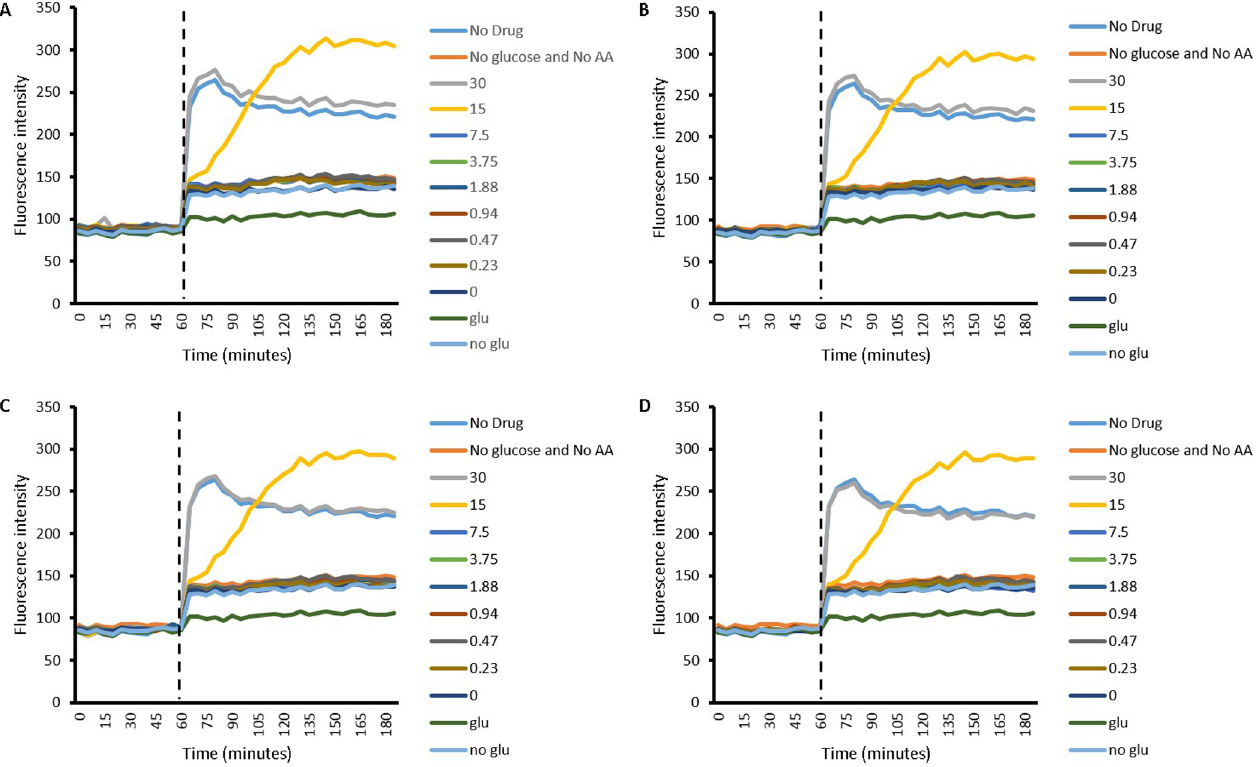
Fig 5. Efflux of EtBr by P . aeruginosa in the presence of different concentrations of L-Asp (30 mM to 0.23 mM). A) 1.06 μ M Cip B) 0.53 μ M Cip C) 0.27 μ M Cip D) 0.13 μ M Cip. In the legend, numbers 0 to 30 represent amino acid concentrations in combination with respective Cip concentration. Firstly, the dashed line represents end of the first part of experiment where Cip and EtBr was allowed to accumulate within energy deprived cells and secondly the start of accumulation in the presence of the amino acid, with or without energy; n = 4.